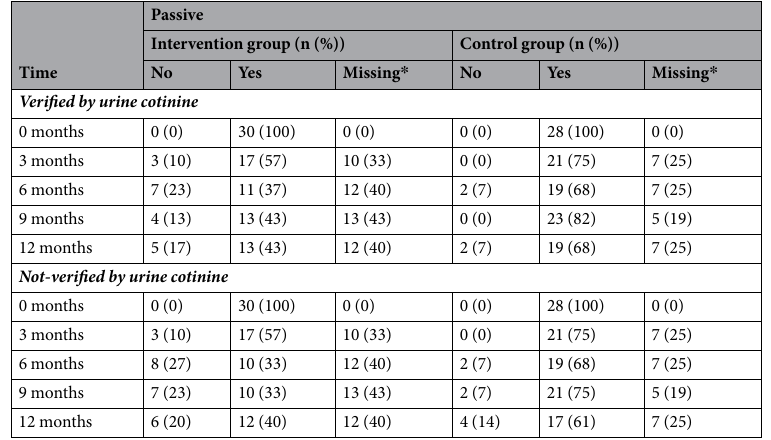
Table 2. Passive smoking verified and not-verified by urine cotinine in the intervention and control group in the course of time. * ‘Missing’ include lost to follow-up as seen in Fig. 1 as well as families who were not lost to follow-up but were not able to participate with one/more of the